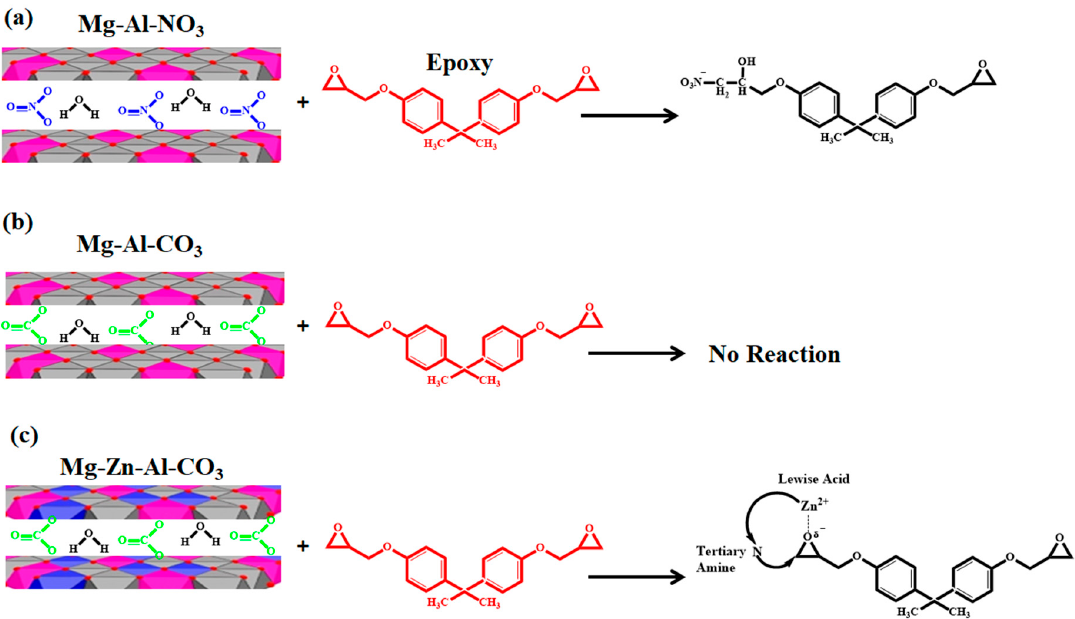
Figure 4. Possible reactions between ( a ) Mg-Al-NO 3 , ( b ) Mg-Al-CO 3 and ( c ) Mg-Zn-Al-CO 3 with epoxy resin.